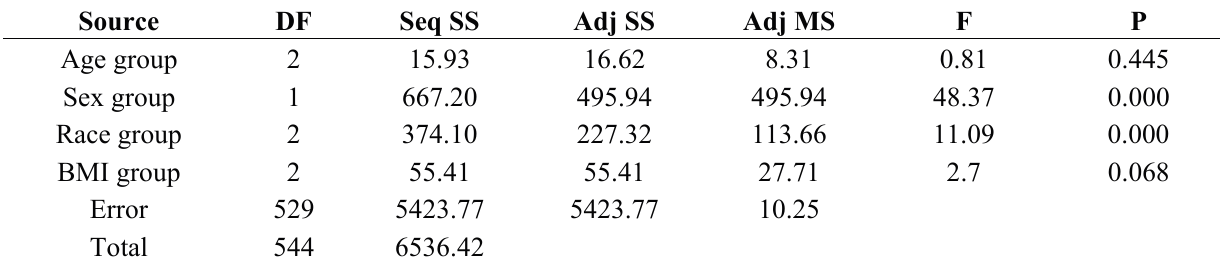
Table 7. Statistical variables from subgroup analysis for estimated and target body fat.